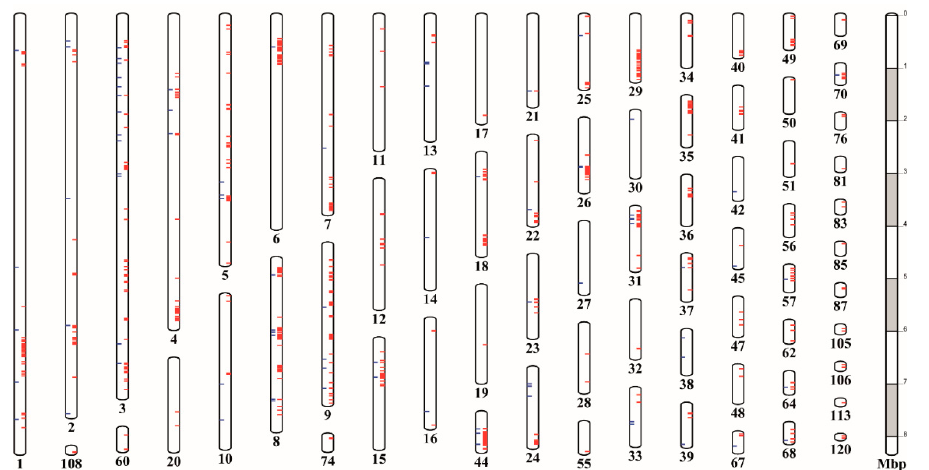
Figure 4. Representation of the physical position of the variant calls identified in PenSeq (blue lines) and ReSeq (red lines) along the G. pallida genome. Each box represents a scaffold of the G. pallida genome [41]. On the right, the scale shows the scaffolds size (in Mbp). Although few of the variant genes identified in the populations selected in both resistances (Supplementary Table S6) were located in some of the islands, there is evidence that these specific genomic regions can function as focal points for genetic selection during biological selection for virulence. Identified members of specific protein families contain variants from selection towards a specific resistance source. From the 178 variant calls found on SPRY domain genes, 147 (i.e., 62 SPRY domain genes out of 85) were associated with the populations developed on H3 . Similarly, BTB/POZ domain proteins (PF00651) were mostly enriched with H3 -selected populations as were two cellulases ( β -1,4-endoglucanase, GHF5 glucanase) (PF00150) that were also identified during the PenSeq. On the other hand, most of the mutations on zinc finger domain proteins (PF00096) were associated with S. vernei -selected populations, whereas those in dorsal gland-expressed genes seem to be associated with both resistances (Supplementary Table S6).